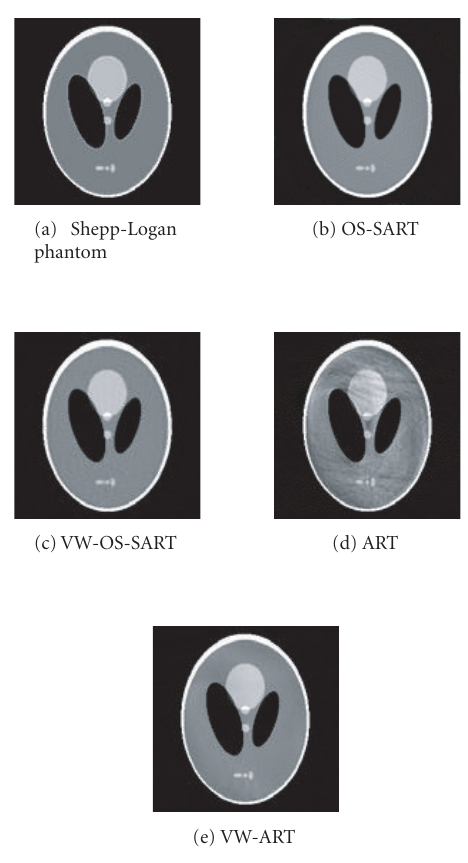
Figure 2: Phantom experiment. The gray range is from 0 to 255. (a) is the Shepp-Logan phantom. (b)–(e) are reconstructed images with the above